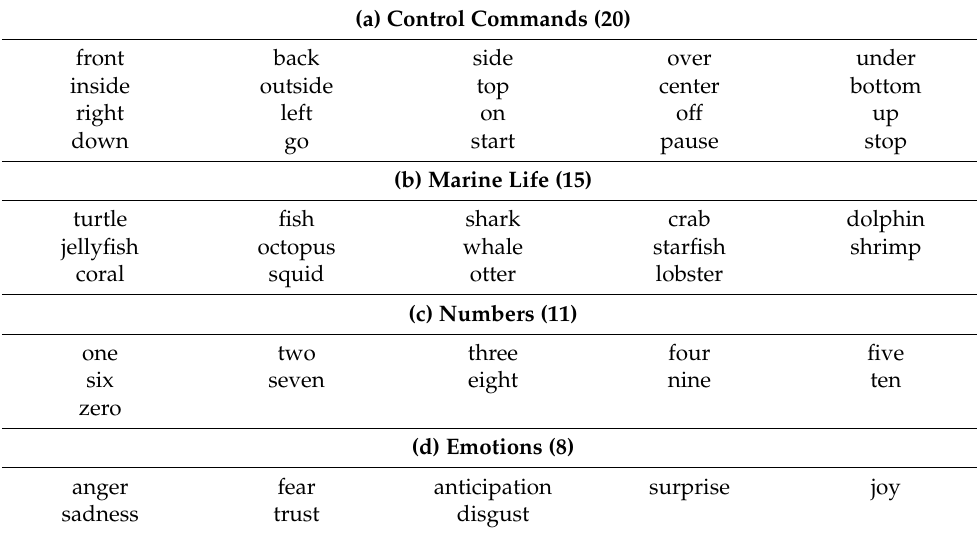
Table 1. Collected speech commands datasets: (a) control commands; (b) marine life; (c) numbers; (d) emotions. (a) Control Commands